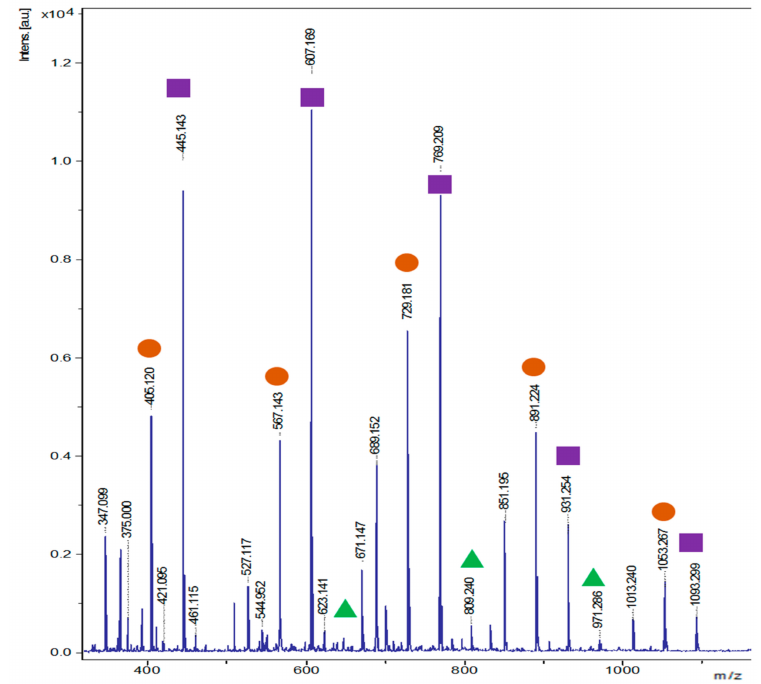
Figure 4. MALDI-TOF MS spectrum of the acetalation product of inulin. The identified acetals (sodium adducts) are marked with orange circles (monoacetals), purple rectangles (diacetals) (purple) and green triangles (triacetals).